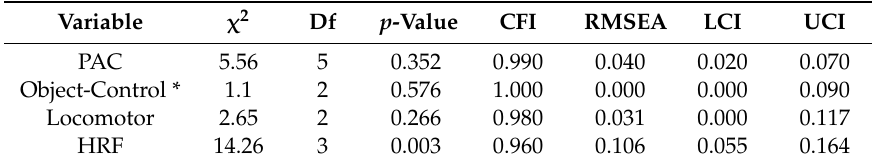
Table 2. Fit indices for latent variables in 6th class.